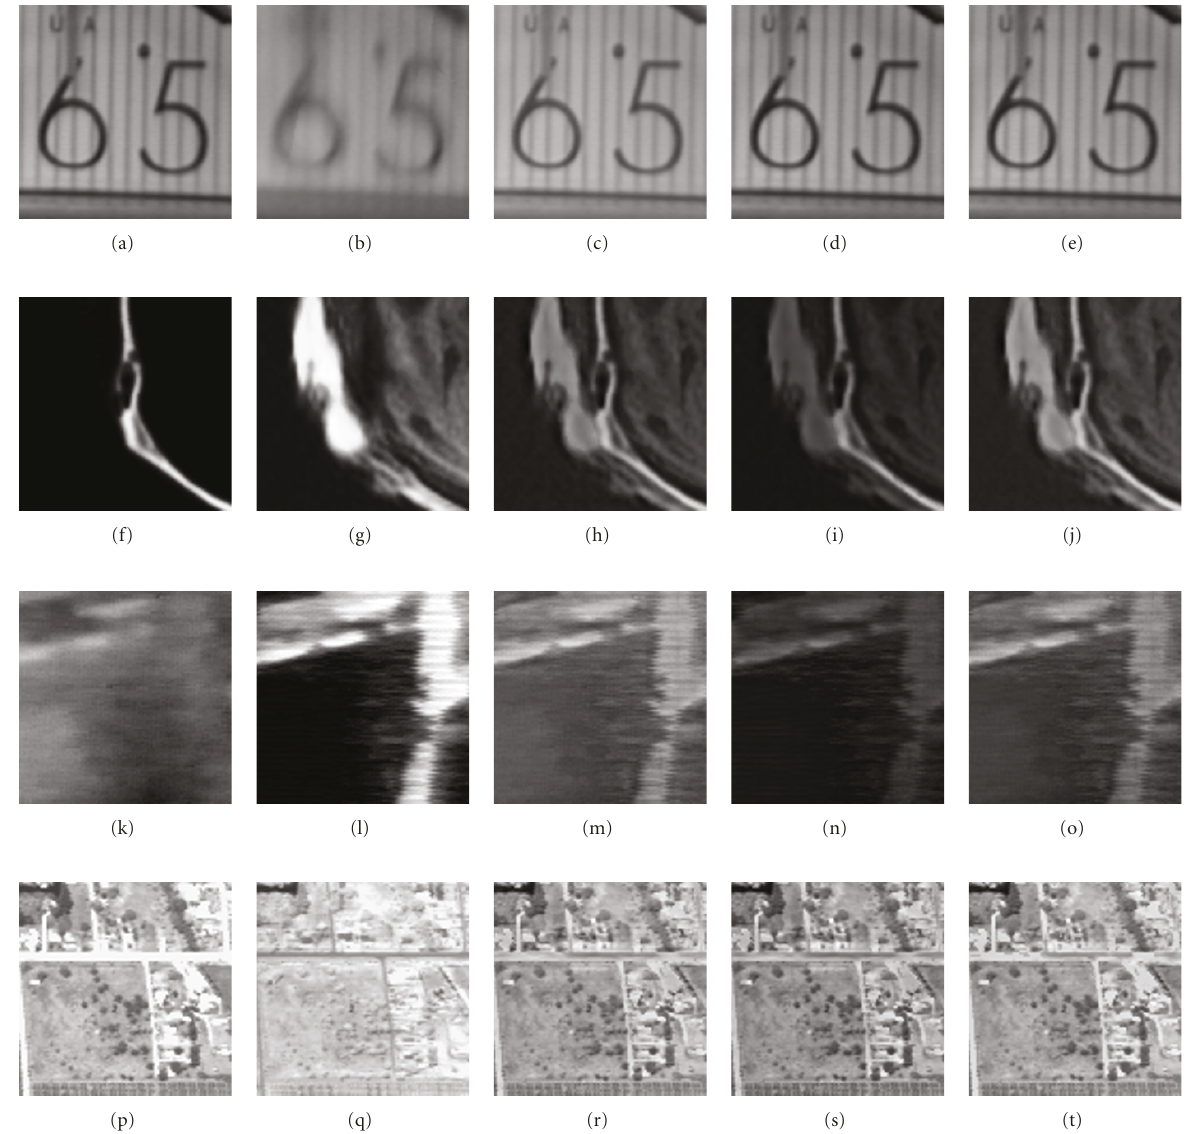
Figure 9: Zoomed regions of (a)and (b) Original “clock” source images, image fusion results using (c) LP and RB, (d) LIP-LP and RB, (e) PL-LP and RB, (f) and (g) original “brain” source images, image fusion results using (h) SWT and RB, (i) LIP-SWT and RB, (j) PL-SWT and RB(k) and (l) original “navigation” source images, image fusion results using (m) DWT and AM, (n) LIP-DWT and AM, (o) PL-DWT and AM(p) and (q) original “remote sensing” source images, image fusion results using (r) SWT and BK, (s) LIP-SWT and BK, (t) PL-SWT and